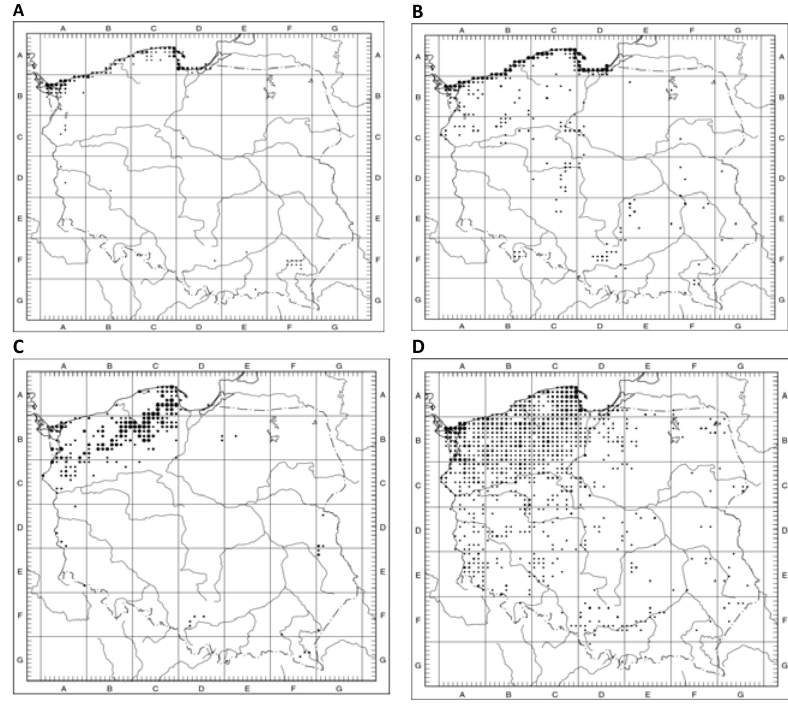
Fig. 3 Concentration of 57 species characterizing Pomerania. ( A ) Taxa associated with different vegetation on saline habitats along the Baltic coast (23 species). ( B ) Dune habitat species (eight species). ( C ) Species entirely located in Pomerania, but do not limit their occurrence only to the coastal strip (11 species). ( D ) Species that have the most numer- ous localities in Pomerania, but also occur in other phytogeographic parts of Poland (15 species). Data are located in a 10 × 10-km ATPOL square cartogram according to